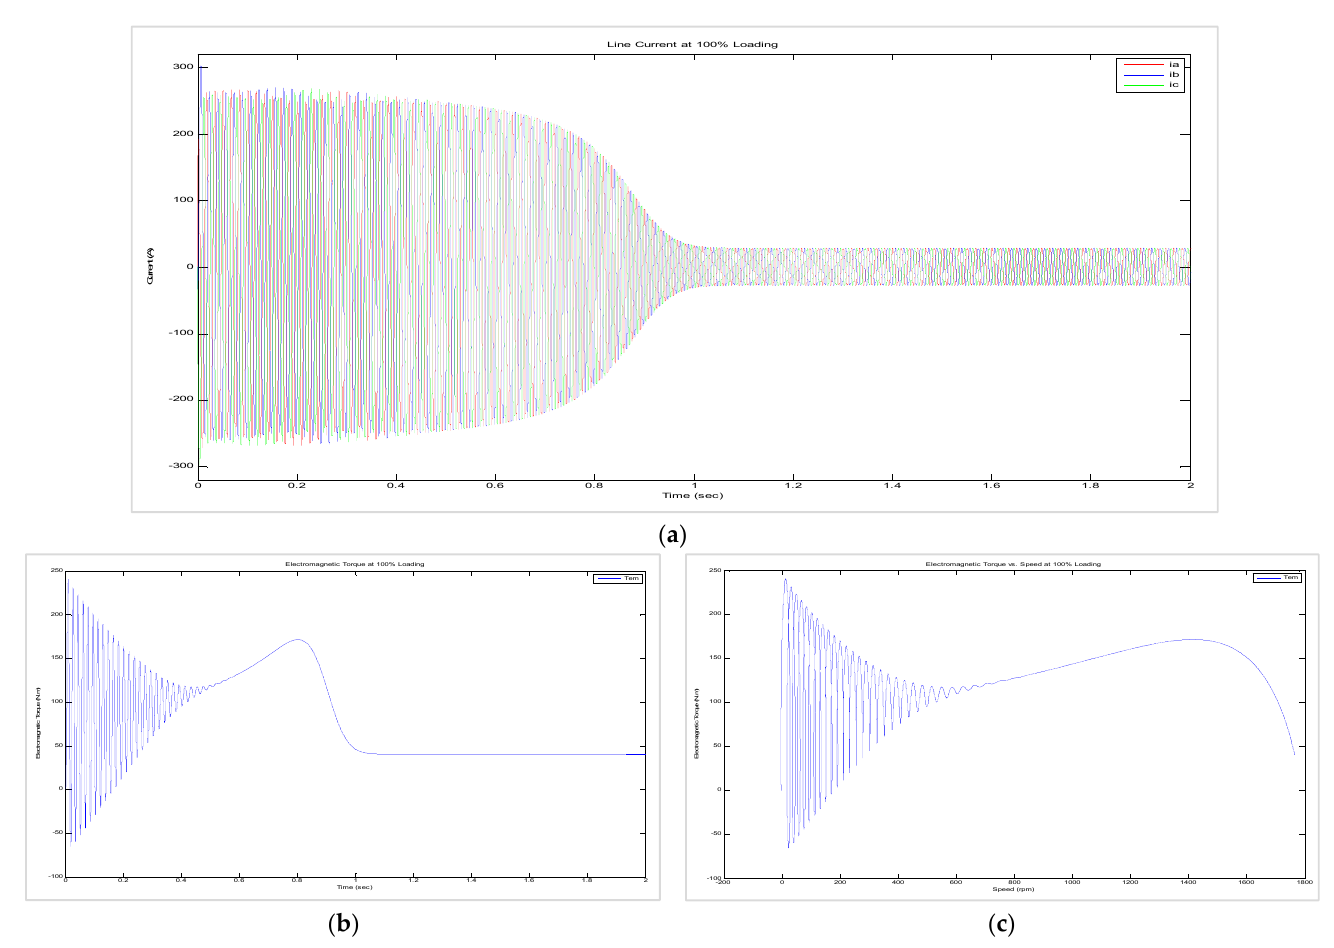
Figure 21. ( a ) Current at 100% loading. ( b ) Electromagnetic torque at 100% loading. ( c ) Electromag- netic torque vs speed at 100% loading. As seen in Figure 22b, the optimal point is at a lower speed than with no-load or half-load.